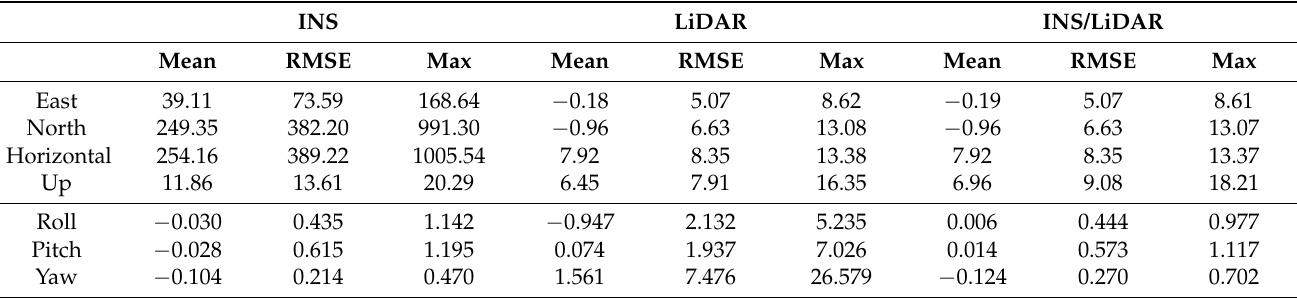
Table A7. D-33—position (m) and attitude (deg) error statistics.